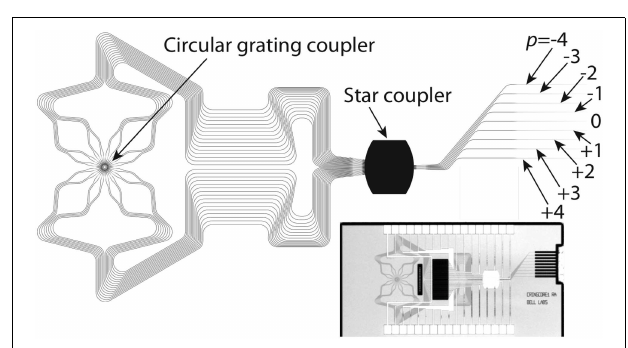
FIGURE 20 | PIC for coupling to the multimodes of a ring-core fiber by using a circular grating coupler connected to a star coupler. The upper figure shows a schematic of the silicon photonic circuit photograph shown at the bottom. The circuit contains a circular grating coupler connected to an array of waveguides of equal length.